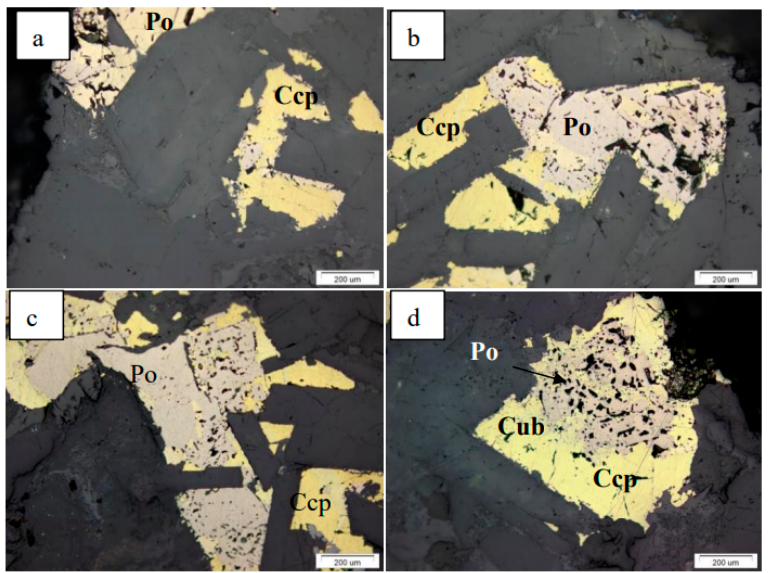
Figure 7. Chalcopyrite-pyrrhotite assemblage in interstitial position between silicate rock-forming minerals, rocks:), ( a ) olivine gabbro-dolerites (sample RG-2/1840), ( b ) taxitic gabbro-dolerites (RG- 2/1824), ( c ) troctolites (RG-2/1805), ( d ) gabbro-dolerites (RG-2/1766), Sample number: borehole/depth,